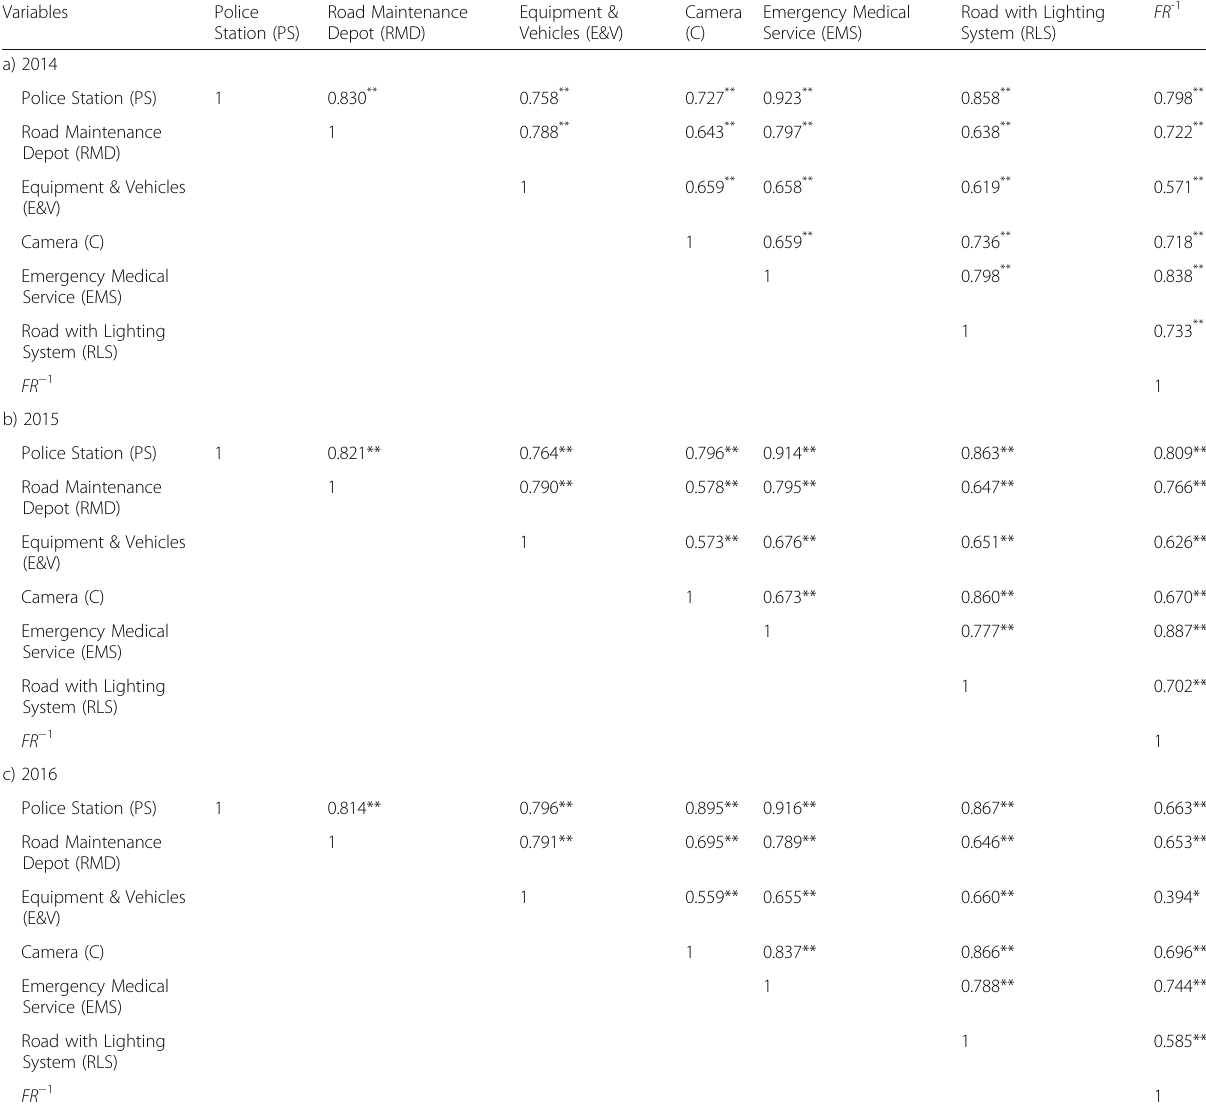
Table 2 Correlation matrix of all